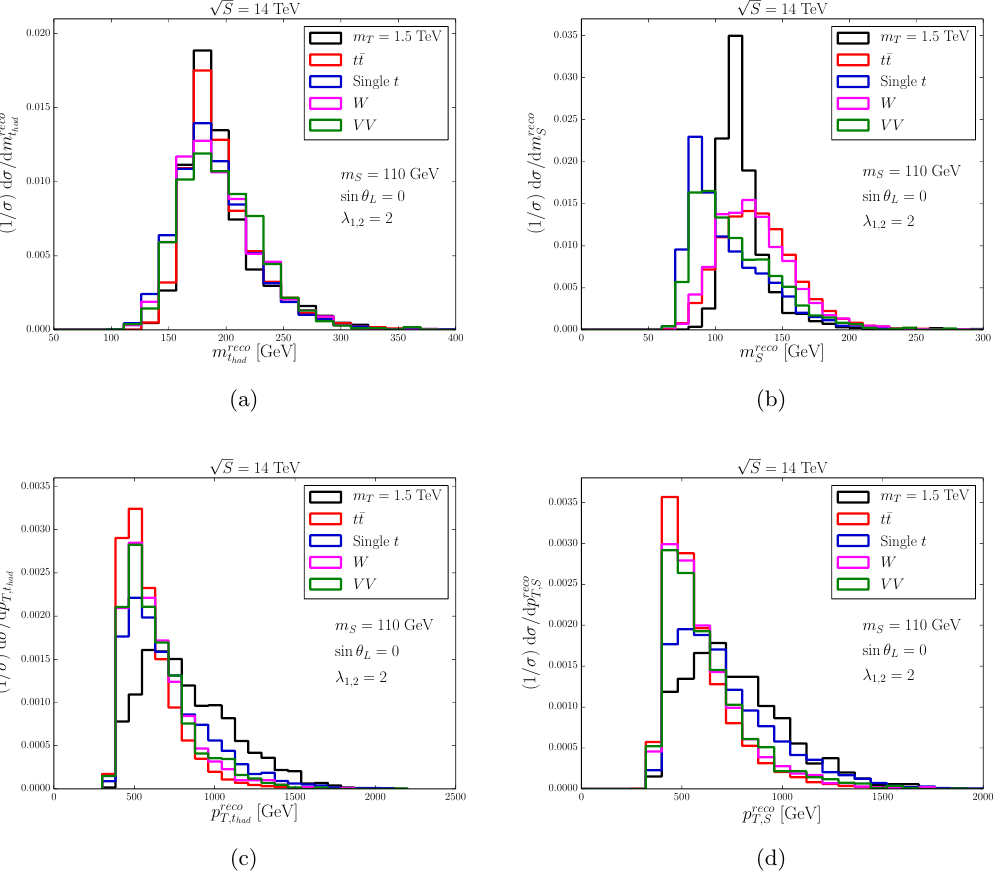
Figure 16 . Reconstructed invariant mass distributions of the (a) top-tagged fat jet and (b) scalar- tagged fat jet for m T = 1 : 5 TeV. The corresponding p T distributions are shown in (c) and (d) together with background distributions. All plots are generated based on events after showering, hadronization, and detector e(cid:11)ects. Our model parameters are m S = 110 GeV, (cid:21) 1 ; 2 = 2 and sin (cid:18) L = 0. Basic cuts in eqs. (6.8){(6.11) have been